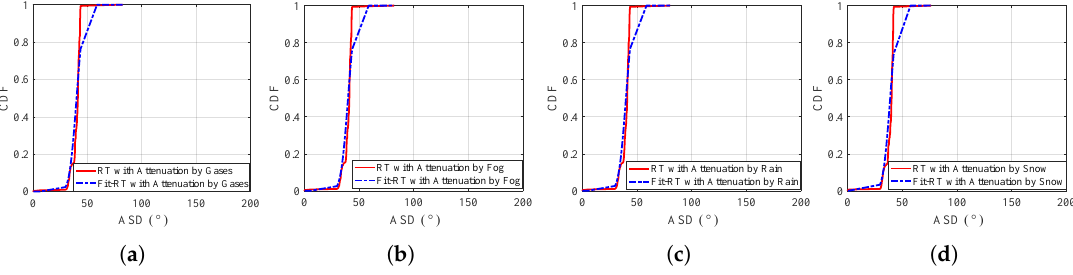
Figure 14. ASD (azimuth angular spread of departure), ( a ) by Gases; ( b ) by Fog; ( c ) by Rain; ( d ) by